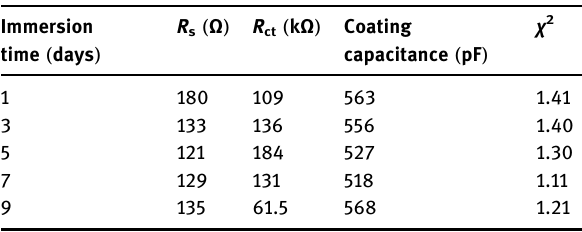
Table 1: Presents the electrochemical impedance ( EIS ) parameter for ROGAU coating under 3.5 wt% NaCl solution at room temperature Immersion